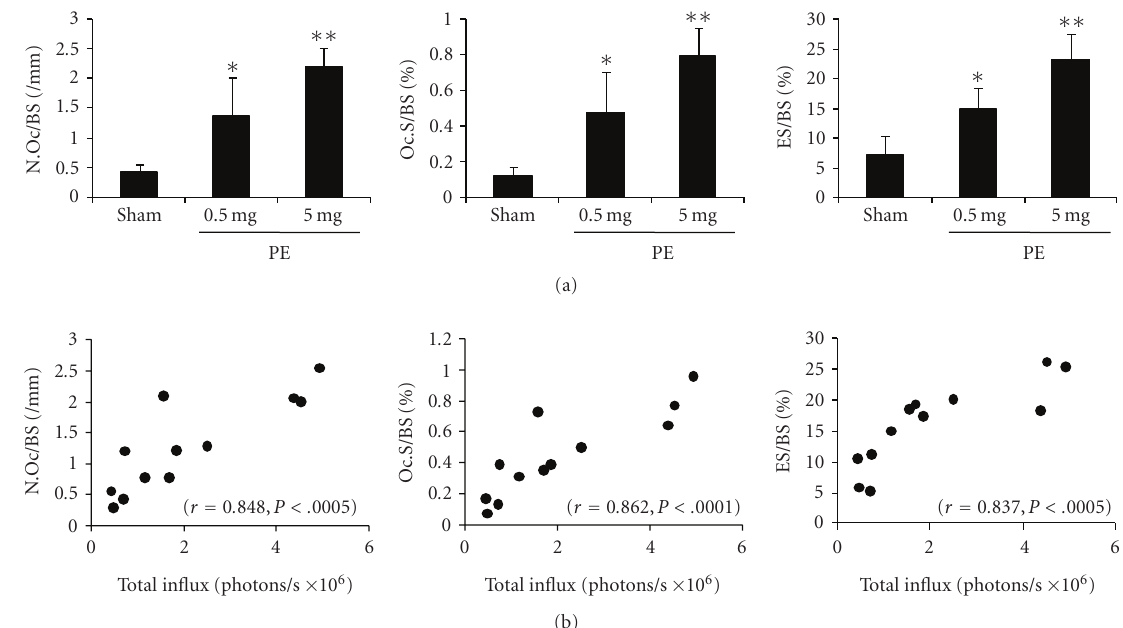
Figure 5: (a) Levels of bone resorption parameters (N.Oc/BS, Oc.S/BS, and ES/BS) as assessed by bone histomorphometry in calvarial tissues retrieved on day 7 after PE loading ( n = 4 per bar, Mean ± SD, ∗ P < . 05, ∗∗ P < . 005 versus sham). (b) Correlation between total influx and levels of bone resorption parameters. The correlation coe ffi cient and P values were r = 0 . 848, P < . 0005 for N.Oc/BS; r = 0 . 862, P < . 0001 for Oc.S/BS; r = 0 . 837, P < . 0005 for ES/BS.